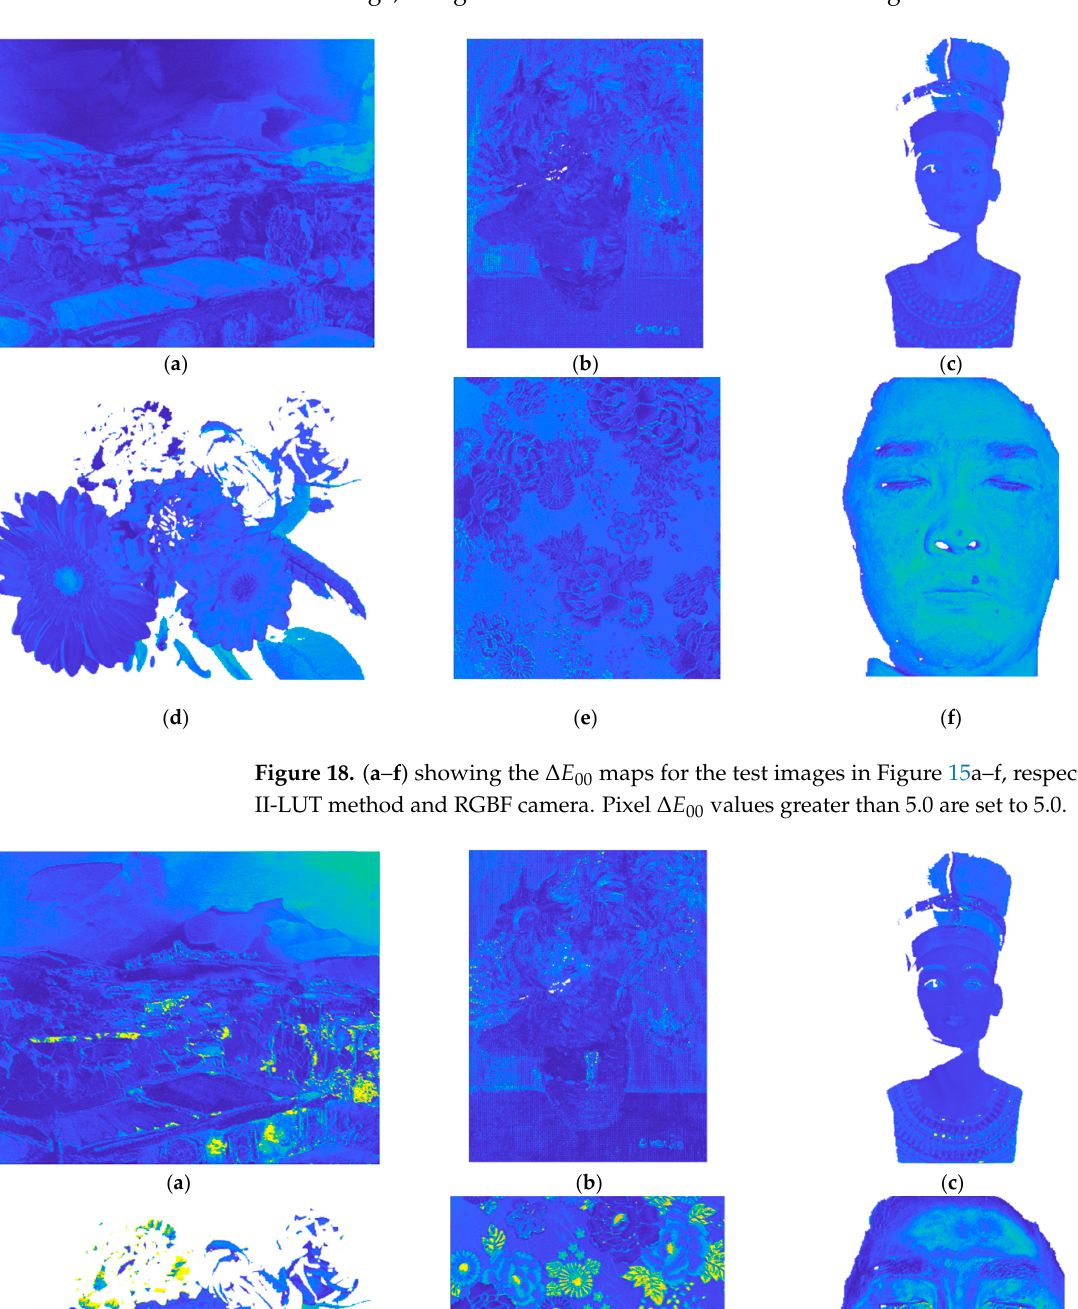
method is significantly better than using the II-wPCA method. For the ∆ E 00 map of the Figure 17. ( a – f ) showing the E Ref maps for the test images in Figure 15a–f, respectively, using the II- “face” image, using the II-LUT method is worse than using the II-wPCA method. wPCA method and RGBF camera. Pixel E Ref values greater than 0.05 are set to 0.05.